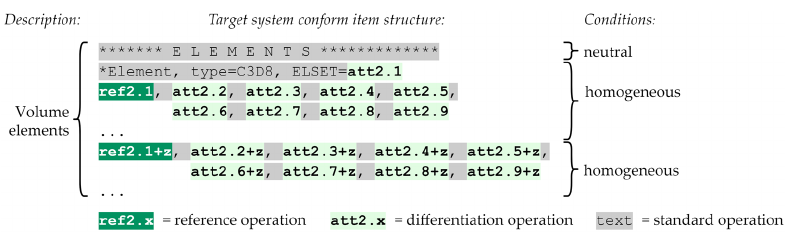
Figure 12. Source system (Gmsh) conforms to the item structure of the element set blocks.